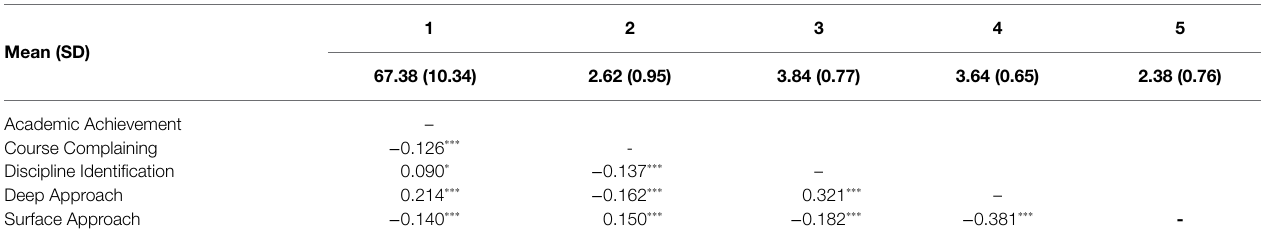
TABLE 1 | Correlations, means, and standard deviations (SD) for key variables.